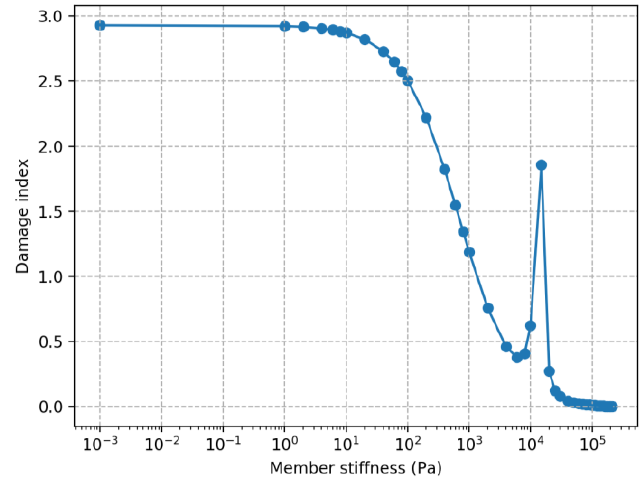
Figure 9. Damage index as simulated leg damage is implemented.